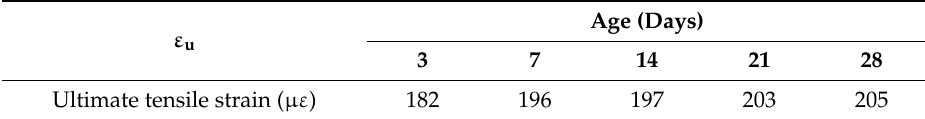
Table 7. Ultimate tensile strain of concrete.